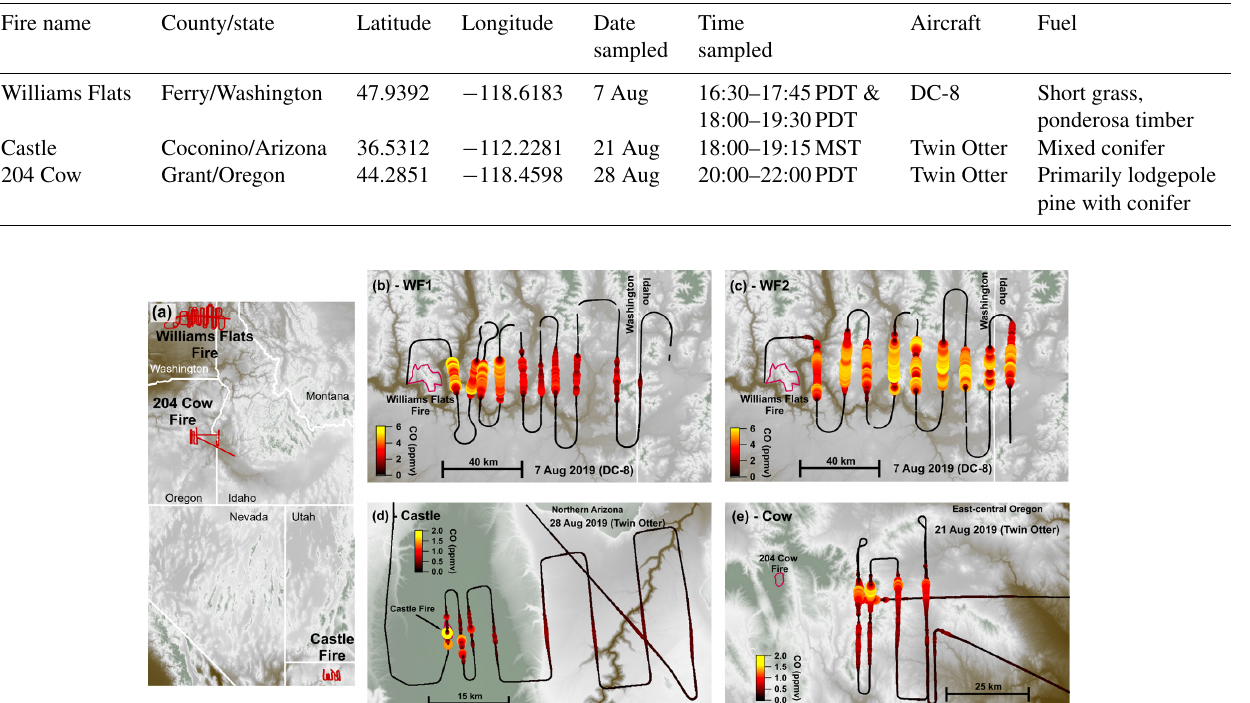
Figure 1. Flight maps colored by elevation. Overview map (a) showing flight tracks (red) with detailed flight maps of the WF1 transects (b) , WF2 transects (c) , Castle transects (d) , and 204 Cow transects (e) . Panels (b) – (e) are colored and sized by CO. Fire boundaries are approximate and indicated by red outlines. The flight path is shown in black and sized by